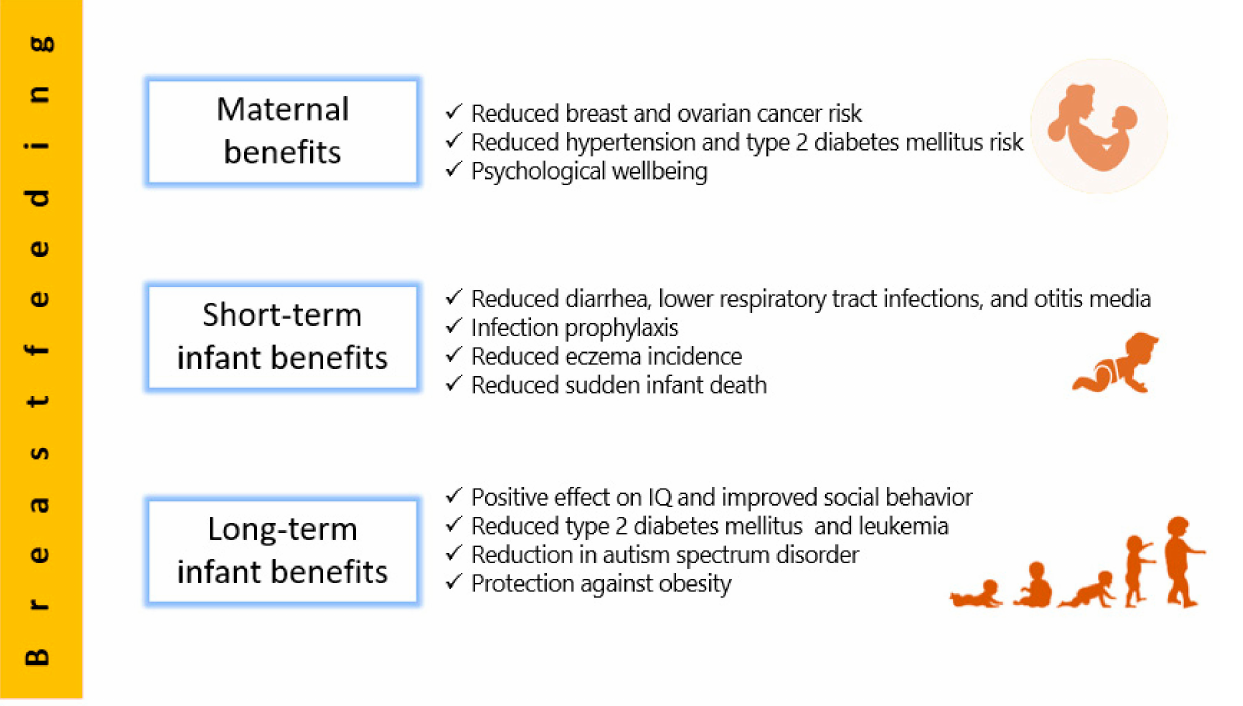
Figure 1. A summarized description of the benefits of breastfeeding and effects of human milk on the early and long-term infant health, as well as benefits for the